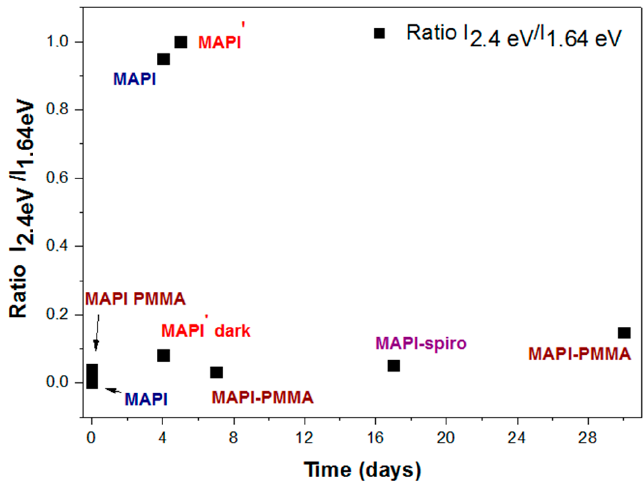
Figure 8. Values of the ratio (I 2.4 eV /I 1.64 eV ) for each considered samples.